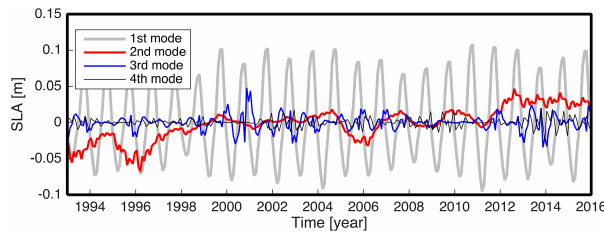
Figure 7. Mean SLA of the four biggest modes of CSEOF decom- position of AVISO around the Korean Peninsula.